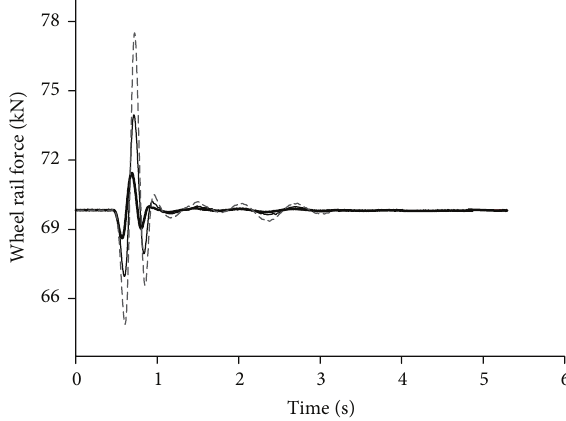
Figure 9: Lateral wheel/rail force (mean value is deducted). Bold line: lateral wheel/rail force of left side; dashed line: lateral wheel/rail force of right side.